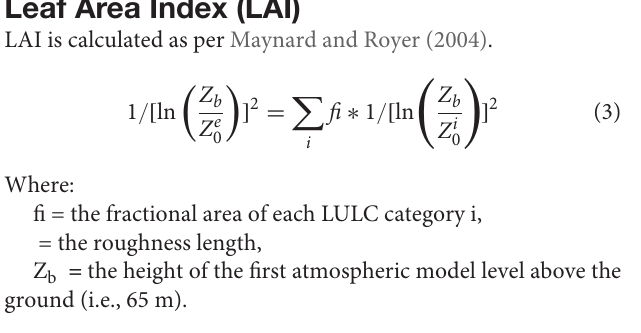
Leaf Area Index